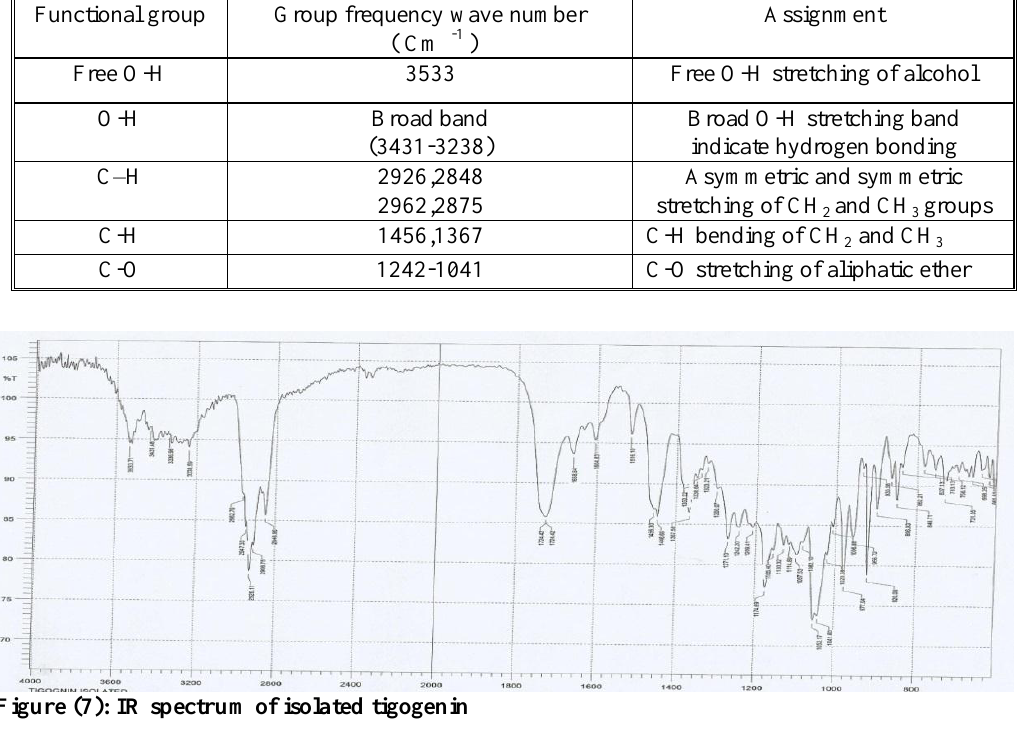
Table (4): ): The most significant group frequencies from FT-IR spectrum of isolated tigogenin .